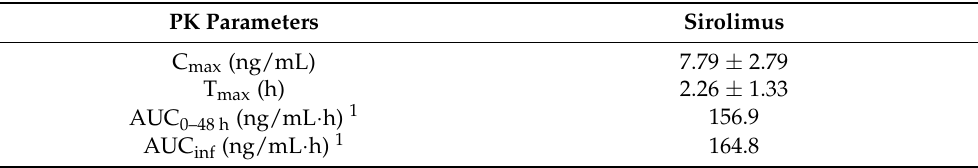
Table 6. Summary of pharmacokinetic parameters in whole blood for sirolimus ( n =